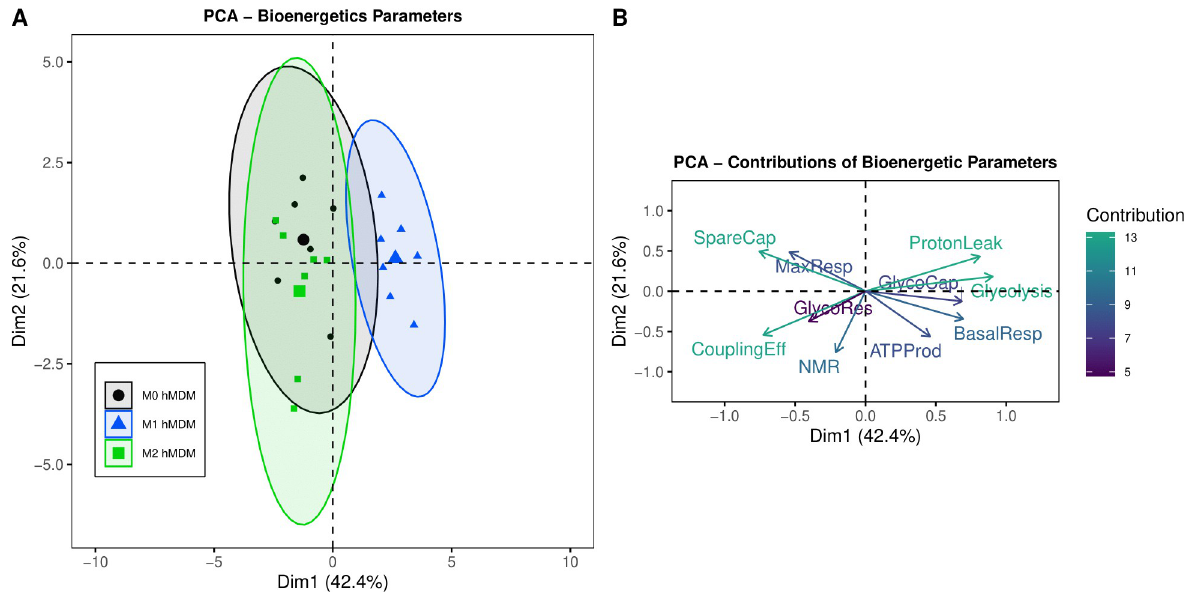
Fig 3. PCA analysis of Seahorse Extracellular Flux bioenergetic parameters. (A) Plot showing clustering of bioenergetic parameters by polarized hMDMs along the first two principal components (Dim1 and Dim2). (B) Percentage contributions of each variable to the variation observed in the first two PCA dimensions. n = 7 biological replicates (3 males, 4 females) with 3–4 technical replicates per biological replicate and polarization state.